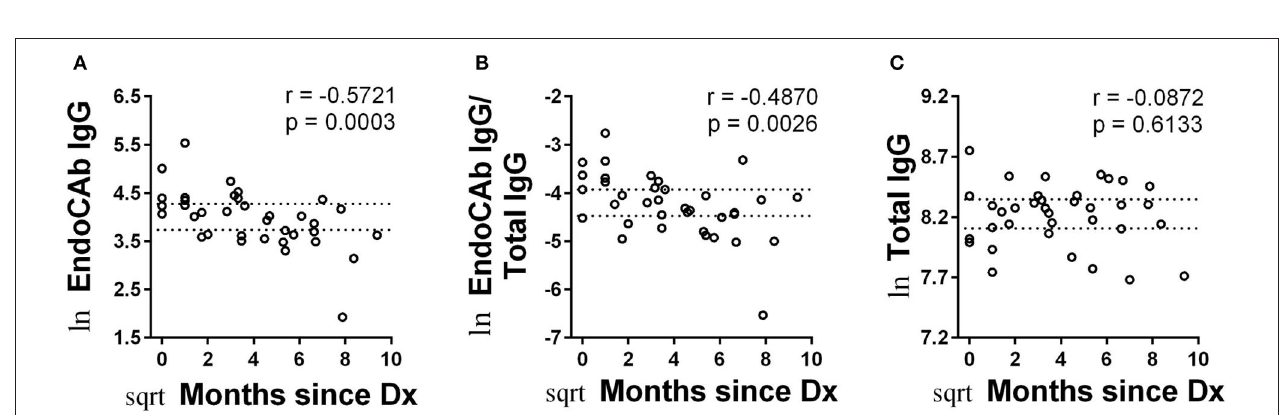
FIGURE 3 | Abundance of EndoCAb IgG decreased with time since diagnosis. (A,B) EndoCAb IgG levels as well as the ratio of EndoCAb IgG to total IgG decrease with months since diagnosis for T1D subjects. (C) Total IgG levels were not significantly associated with months since diagnosis. Dotted lines represent upper and lower 95% confidence intervals based on control subjects for each analyte and are included for reference. Data were normalized using natural logarithm (ln) and square root (sqrt)